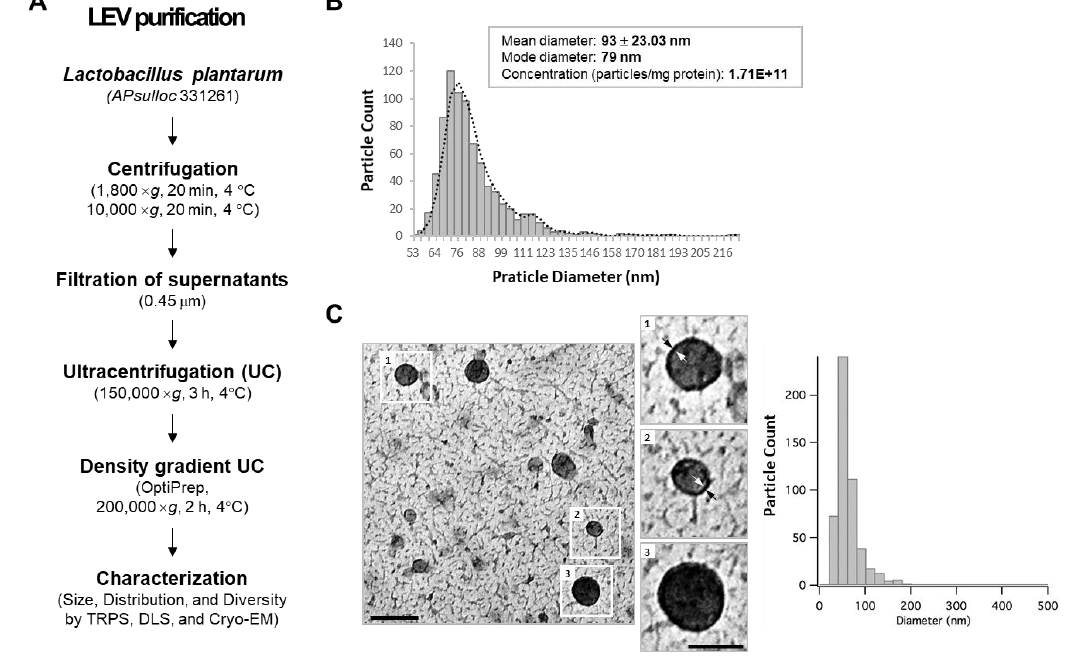
Figure 1. Lactobacillus plantarum APsulloc 331261 spontaneously releases extracellular vesicles. ( A ) Scheme for L. plantarum APsulloc derived extracellular vesicle (LEV) purification. ( B ) Size distribution, dispersity, mean diameter/mode diameters, and concentration of purified LEVs based on tunable resistive pulse sensing (TRPS) analysis using qNano-Gold. ( C ) Cryo-TEM image of LEVs